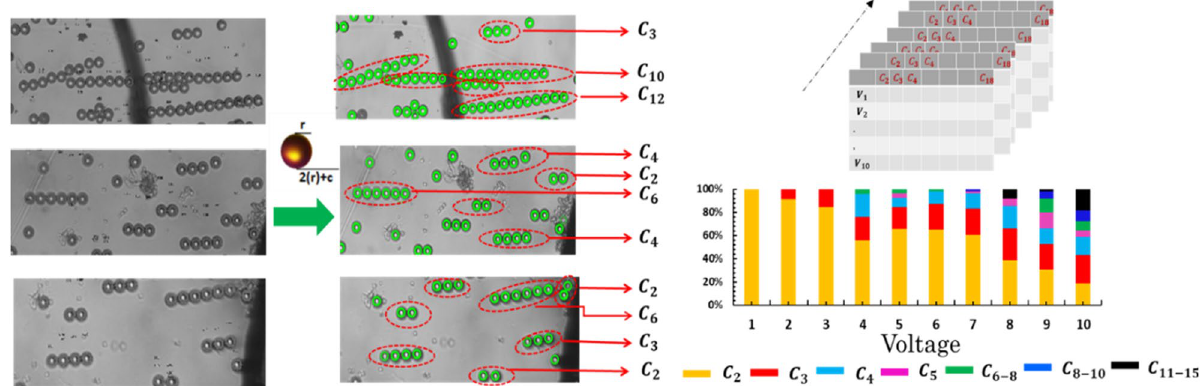
Figure 2. Pearl chain analysis using a Template-Based Matching algorithm and particle coordinate search algorithm. A template image is shifted across the DEP micrographs by an offset (x, y) using the origins of the two images as reference points. Pearl chain lengths (Li) is determined using a particle coordinate search